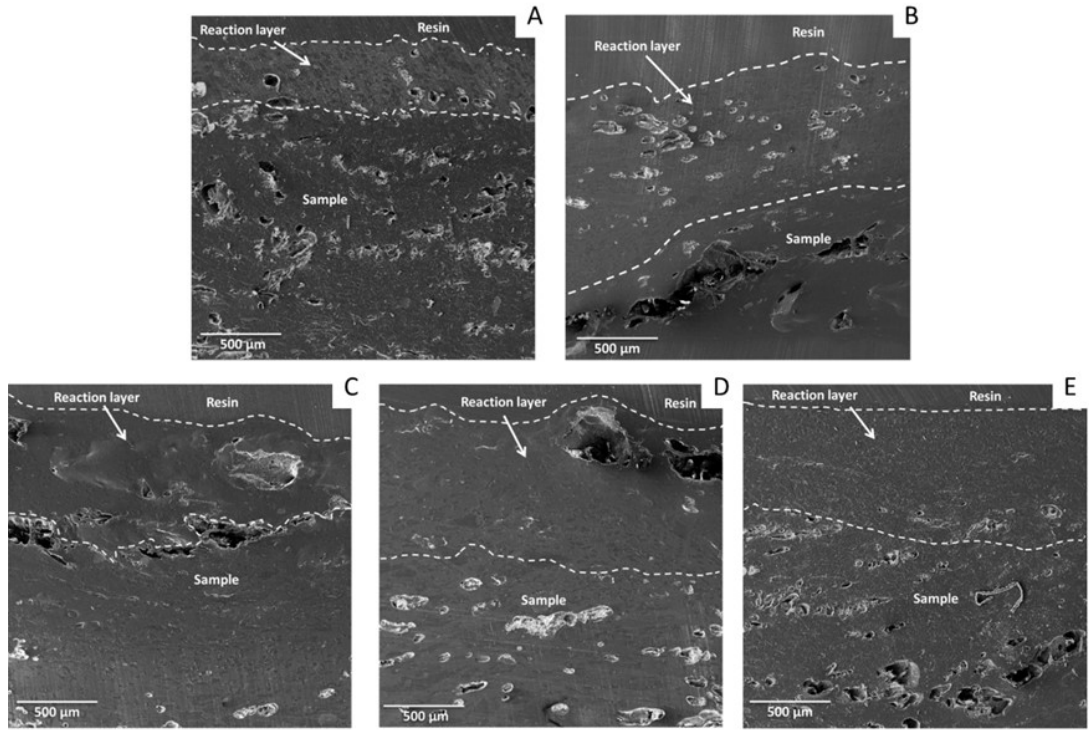
Figure 7. Cross-sections of samples EPDM 1 (A), EPDM 2 (B), EPDM 3 (C), EPDM 4 (D), and EPDM 5 (E).